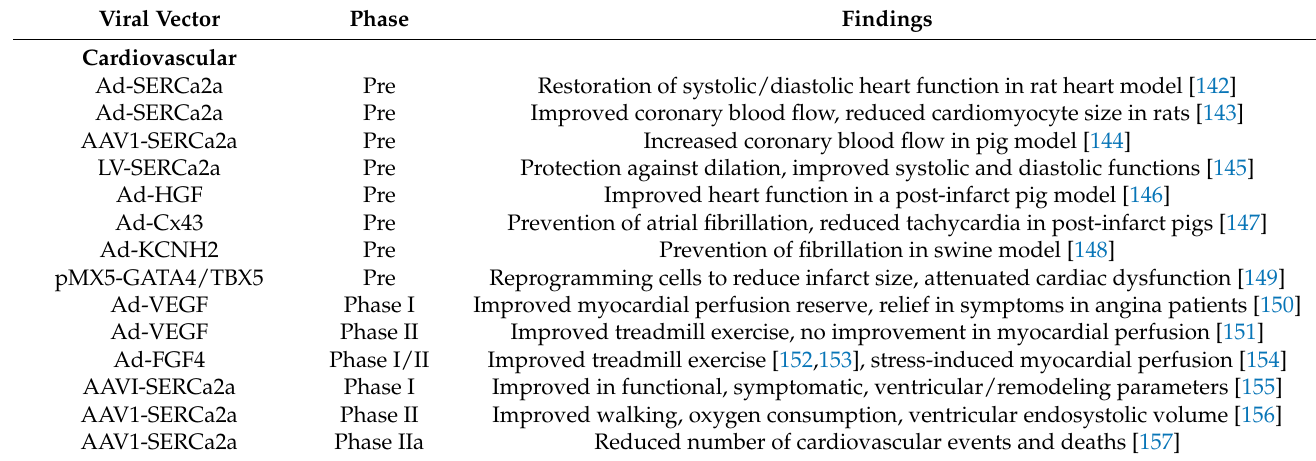
Table 3. Preclinical and clinical examples of viral vectors applied for cardiovascular, metabolic, and hematological